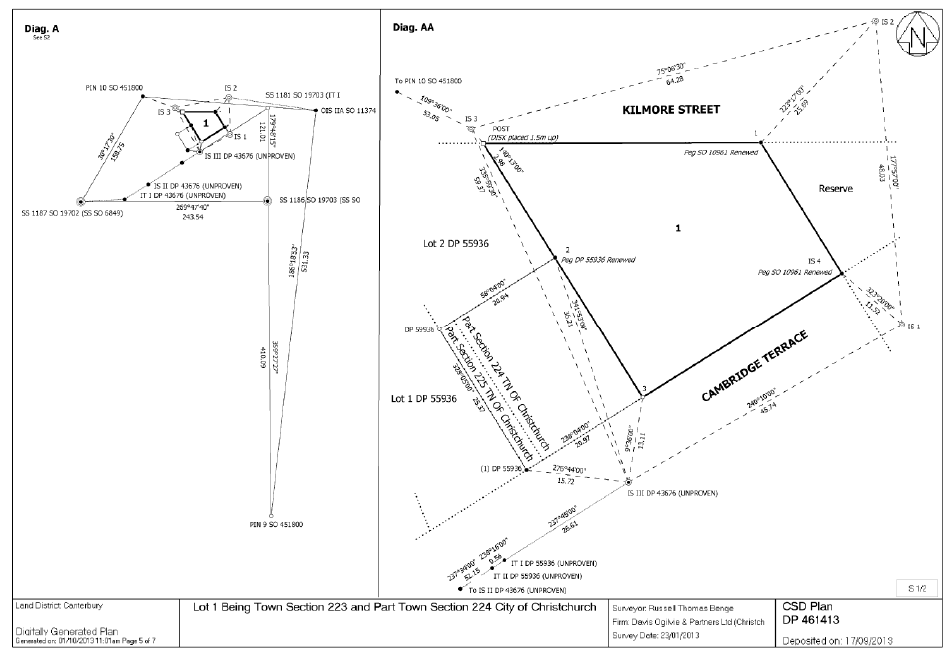
Figure 4. Static diagram image (plan) of cadastral survey dataset.